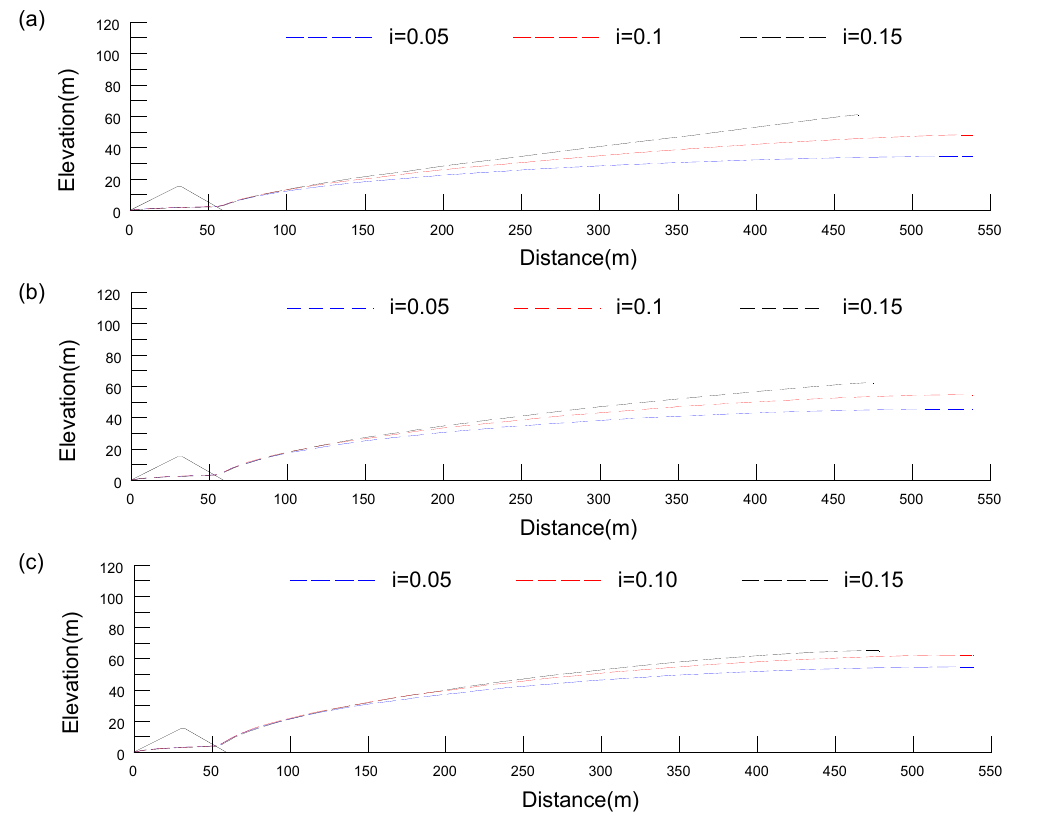
Figure 12. Distribution of the saturation line under different terrains of the tailings pond: ( a ) Taiyuan (annual rainfall of 400 mm); ( b ) Zhengzhou (annual rainfall of 800 mm); ( c ) Guiyang (annual rainfall of 1200 mm).